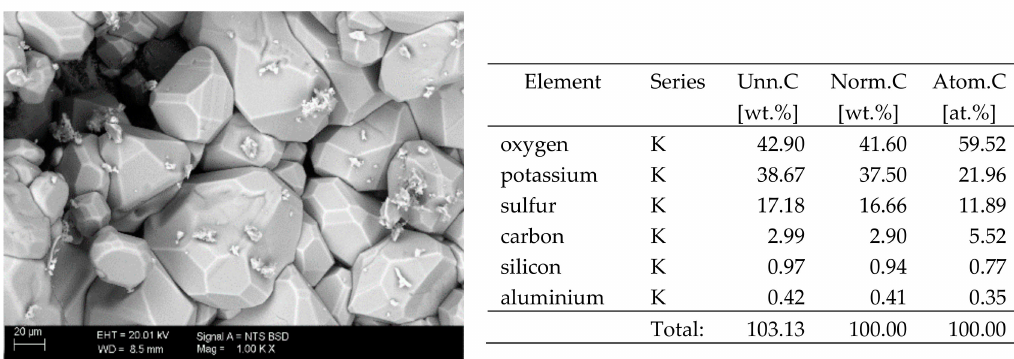
Figure 8. SEM image of the microstructure of K 2 SO 4 crystals visible on the surface of the bricks tested; 1000 × magnification. Next to it is a screenshot an EDS analysis for presence of crystals.